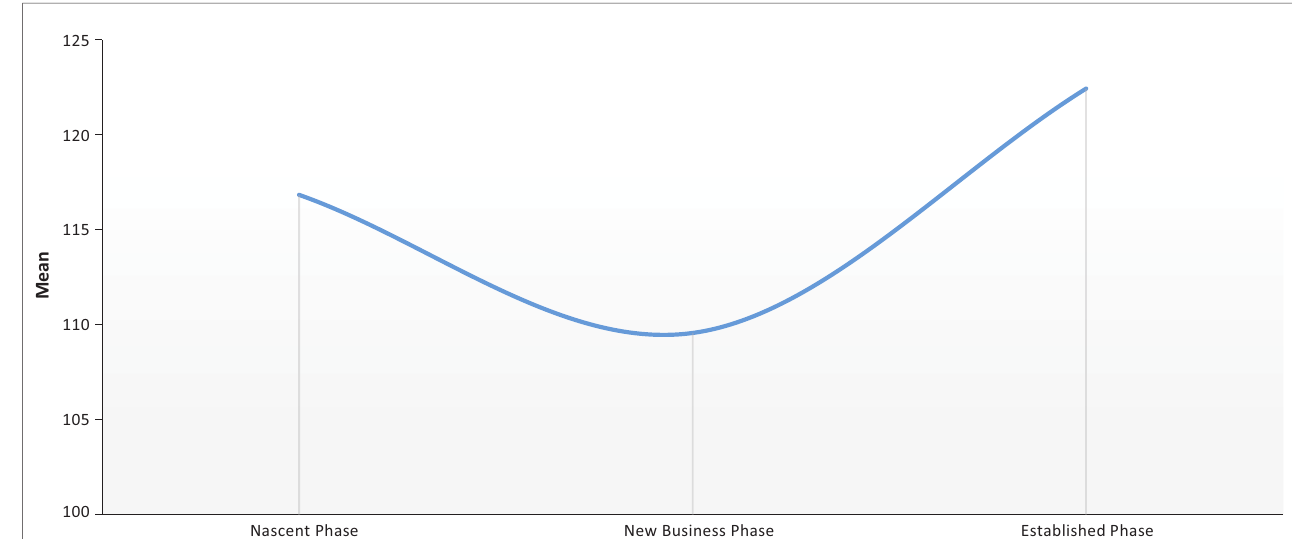
FIGURE 2: Human capital investments utility across the entrepreneurship